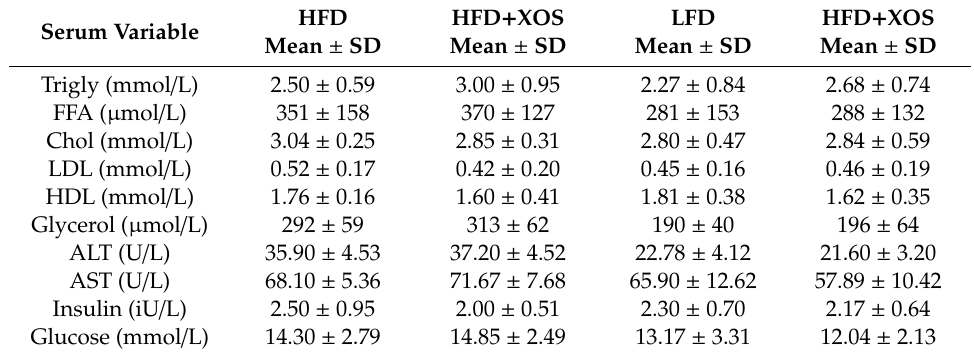
Table 2. Serum clinical variables after the 12 weeks of diet intervention. The values are presented as mean ± standard deviation (SD). n = 8–10 / diet group.